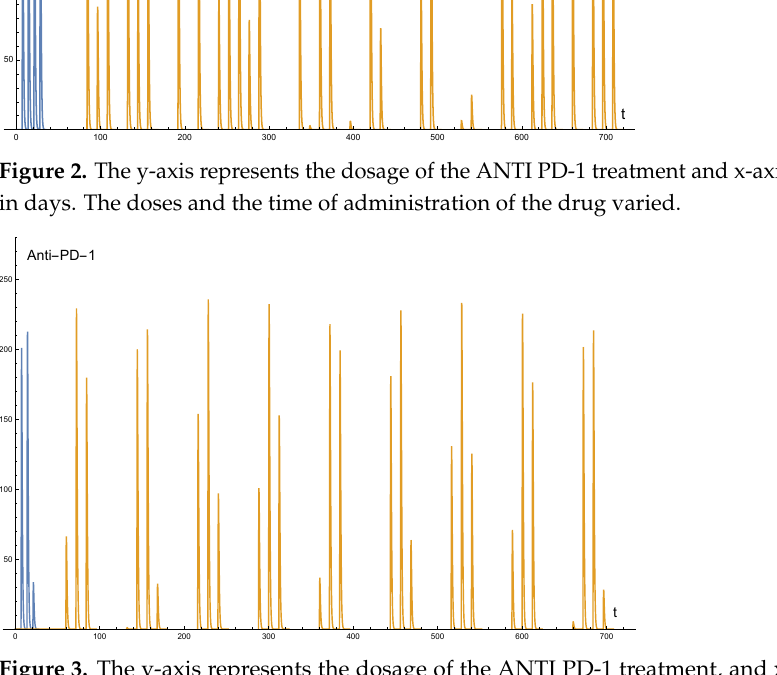
Figure 3. The y-axis represents the dosage of the ANTI PD-1 treatment, and x-axis represents the time in days. The doses and the time of administration of the drug